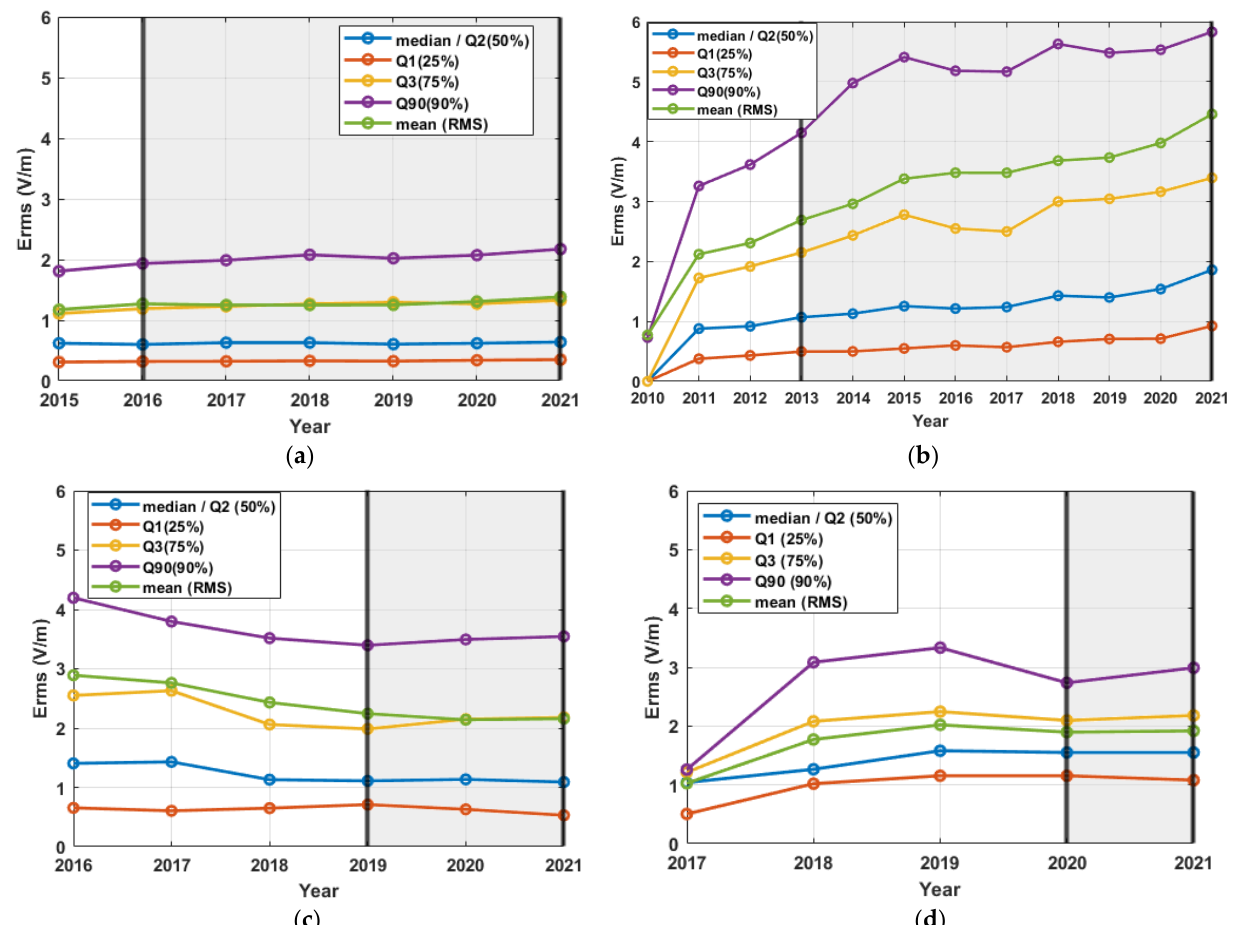
Figure 5. Temporal evolution of E-field levels for four monitoring networks: ( a ) Greece, ( b ) Catalonia in Spain, ( c ) Romania, and ( d ) Serbia. Median, mean (rms), and several percentiles’ values for the yearly E rms distribution of each network are shown. The time period where at least 75% of monitoring sensors are active is indicated between black vertical lines in grey-shaded background, for each network.